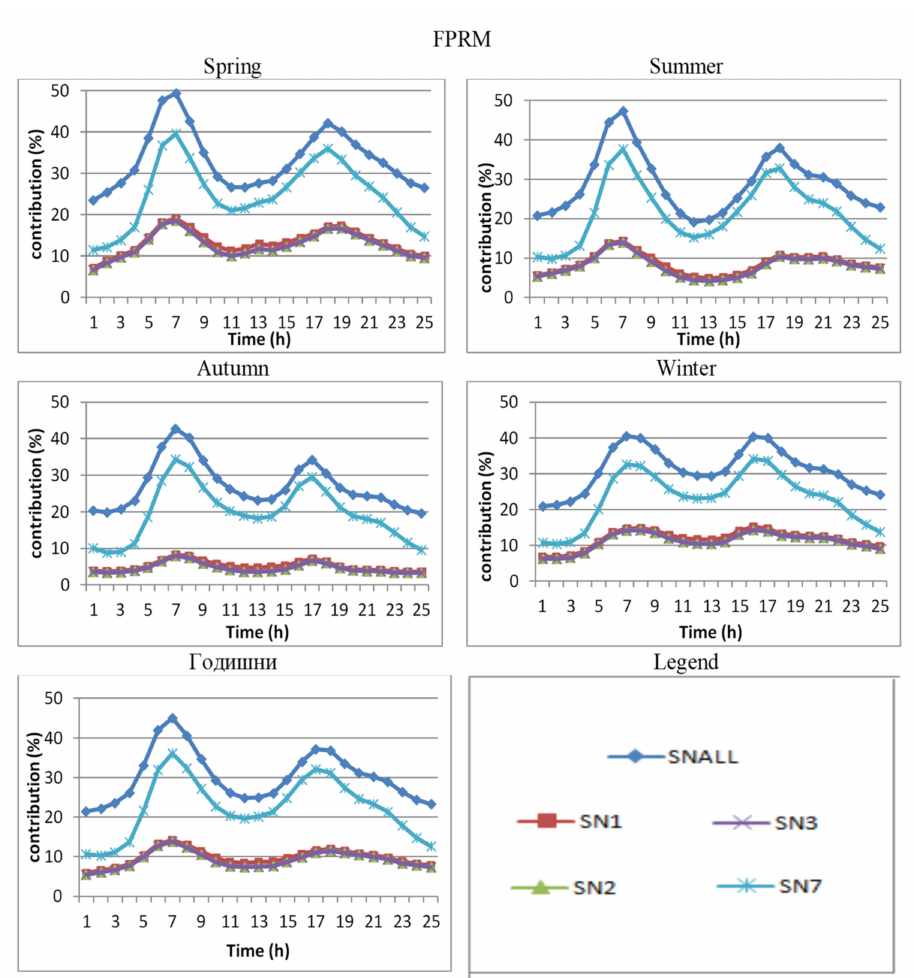
Figure 6. Annual and seasonal averaged relative contribution (%) of all emissions and the emissions from different SNAP categories of the formation of FPRM concentrations for Sofia for the period